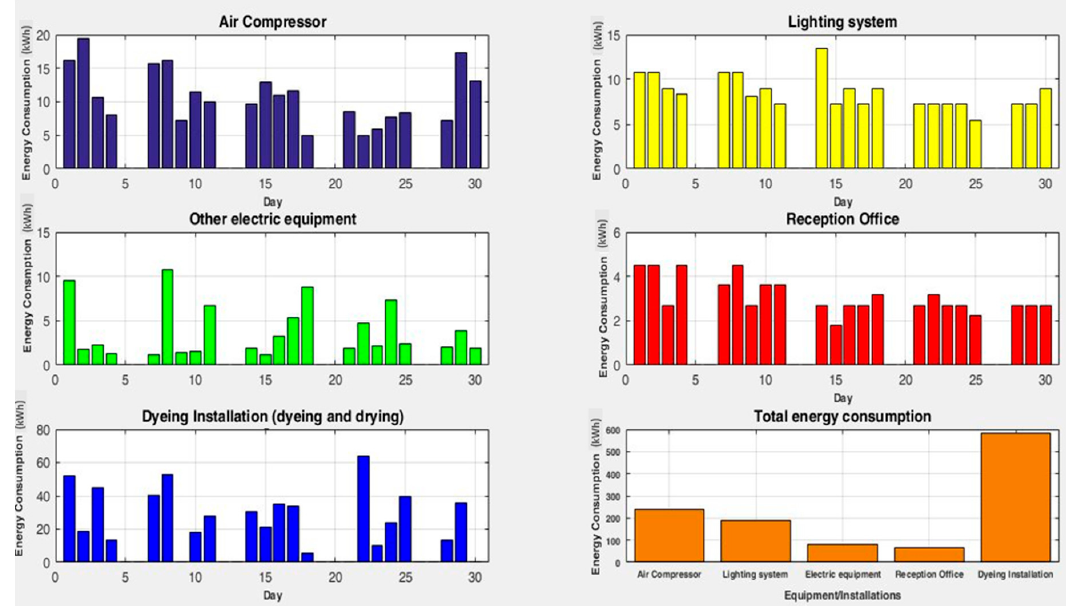
Figure 14. Daily electricity consumption for each equipment and installation in analysed period.